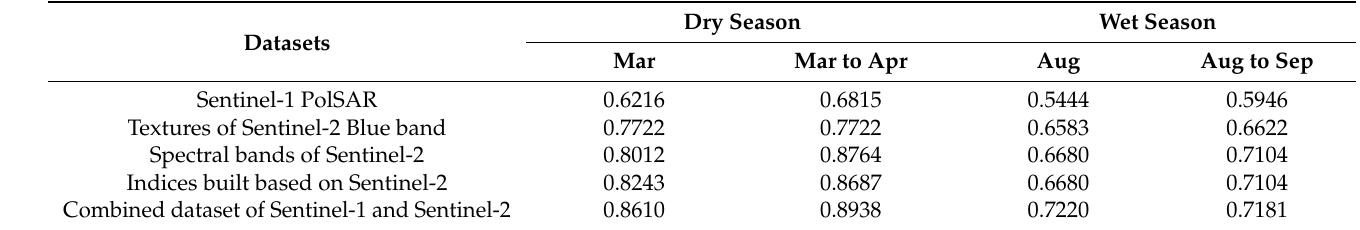
Table A3. The accuracies of each dataset in the different time intervals during wet and dry season.